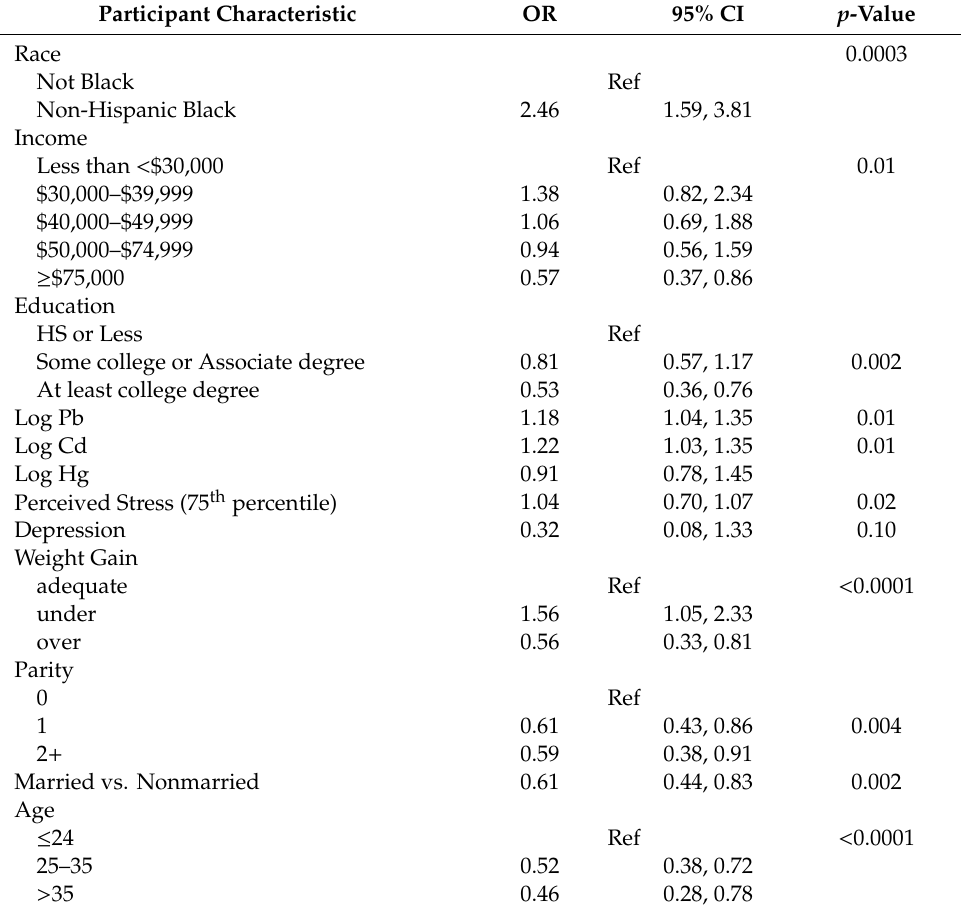
Table 2. Bivariate analysis comparing exposures and confounders to small for gestational age (SGA), the Fetal Growth